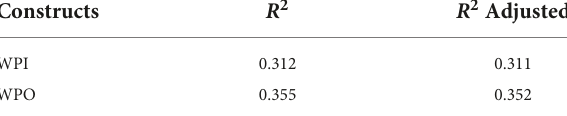
TABLE 3 Coefficient of determination ( R 2 ).